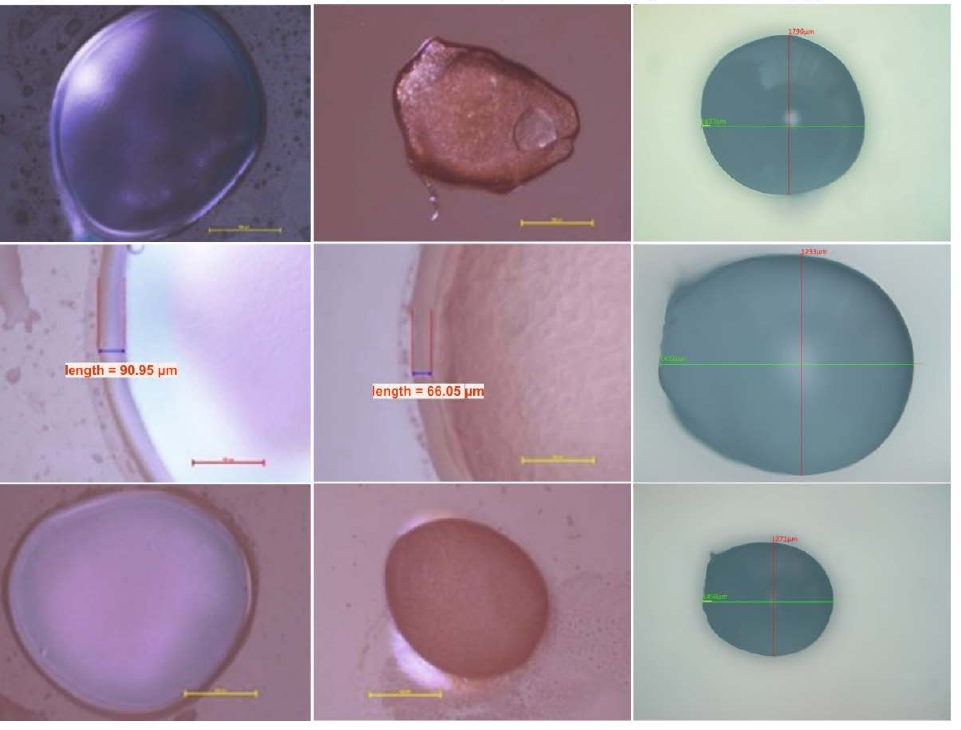
Figure 6. Examples of optical microscopy images of capsules loaded with pine, thyme, and pepper- mint essential oils.